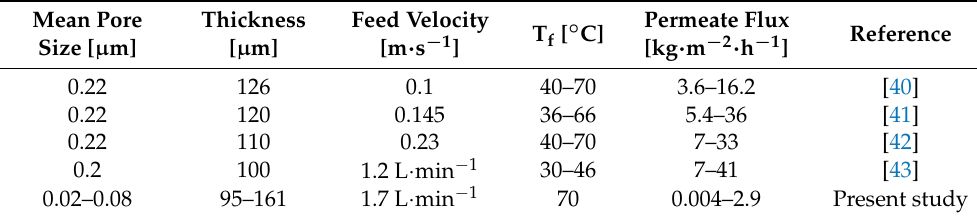
Table 6. Pure water permeate flux of PVDF membranes in the DCMD process.